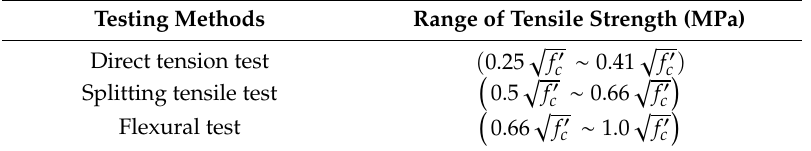
Table 1. Approximate range of concrete tensile strength obtained by di ff erent methods